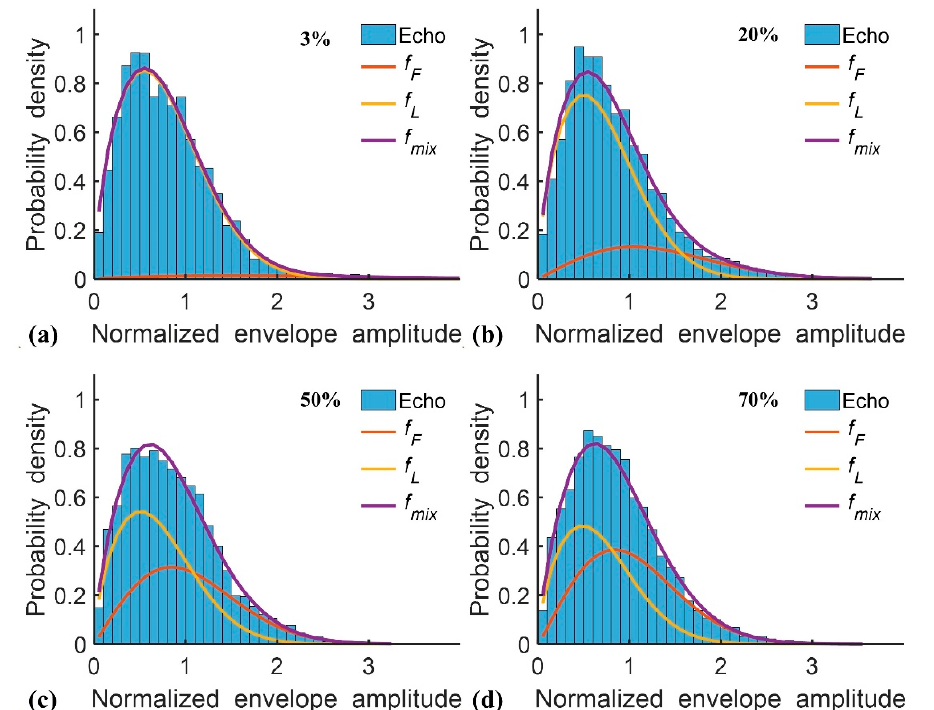
Figure 3. Probability density distributions of the DND mode constructed using the expectation- maximization (EM) method, representing that f F varies with increasing grades of hepatic steatosis. ( a ) 3%; ( b ) 20%; ( c ) 50%; ( d ) 70%.